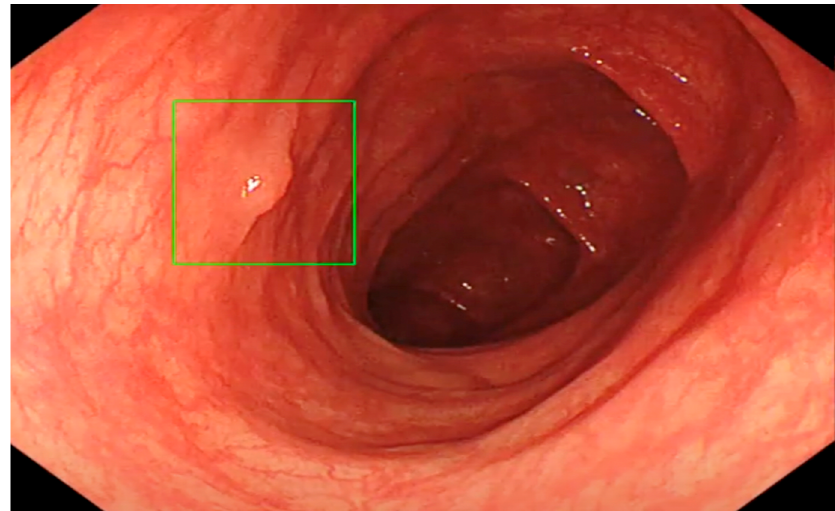
Figure 4. Diminutive polyp detected by CADe AI .